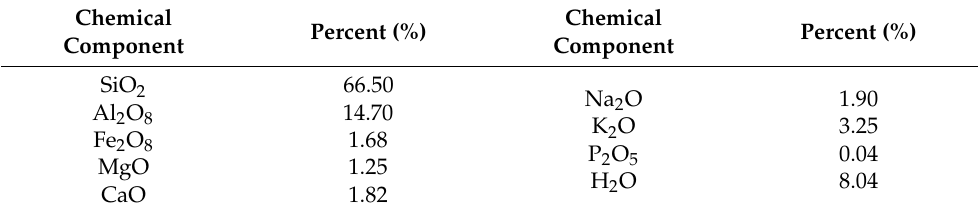
Table 4. The chemical composition of clinoptilolite used in this study.